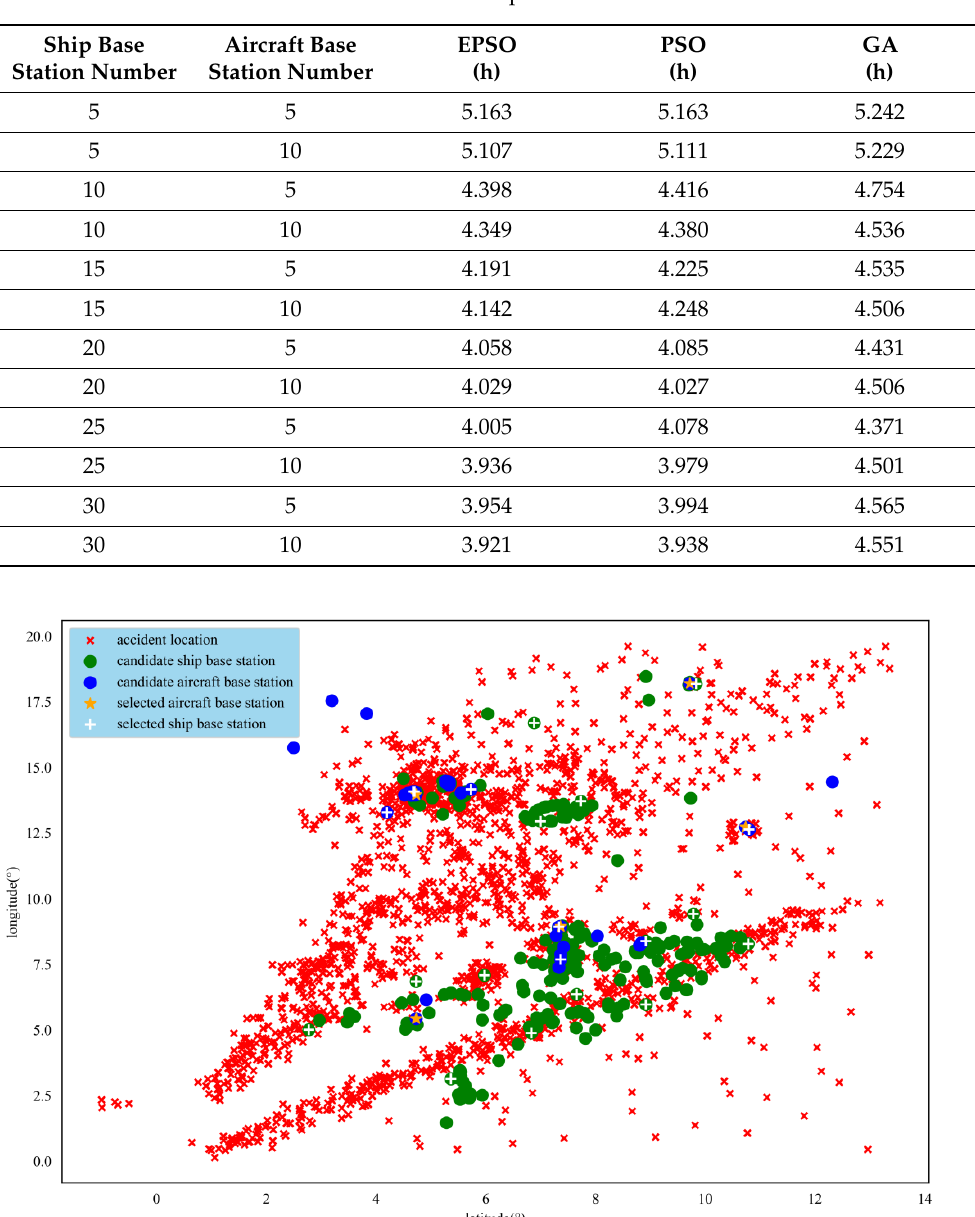
Figure 6. Base station allocation strategy with EPSO model under constraint of 20 ship and 5 aircraft base stations.